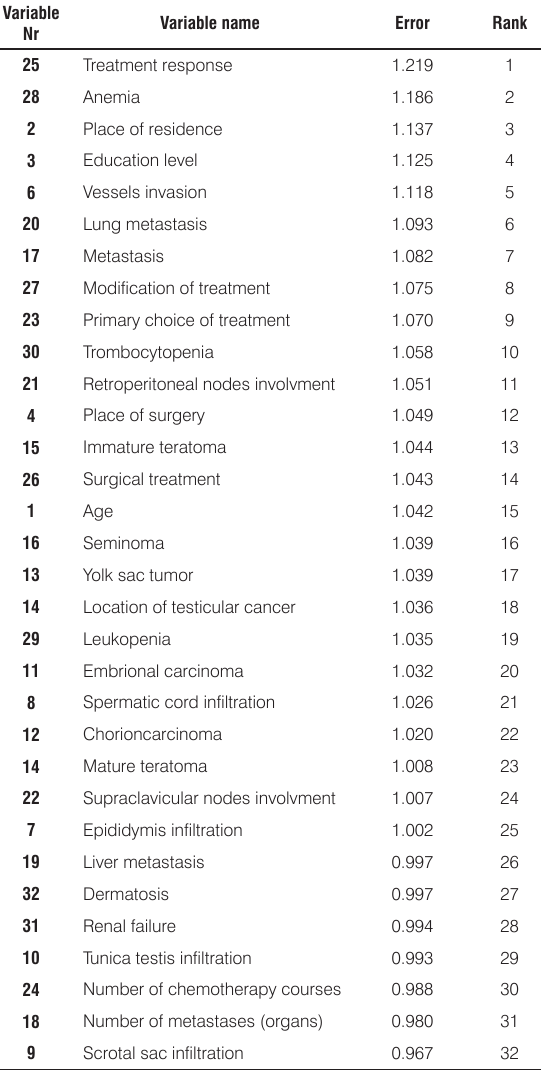
Table 4. Sensivity analysis